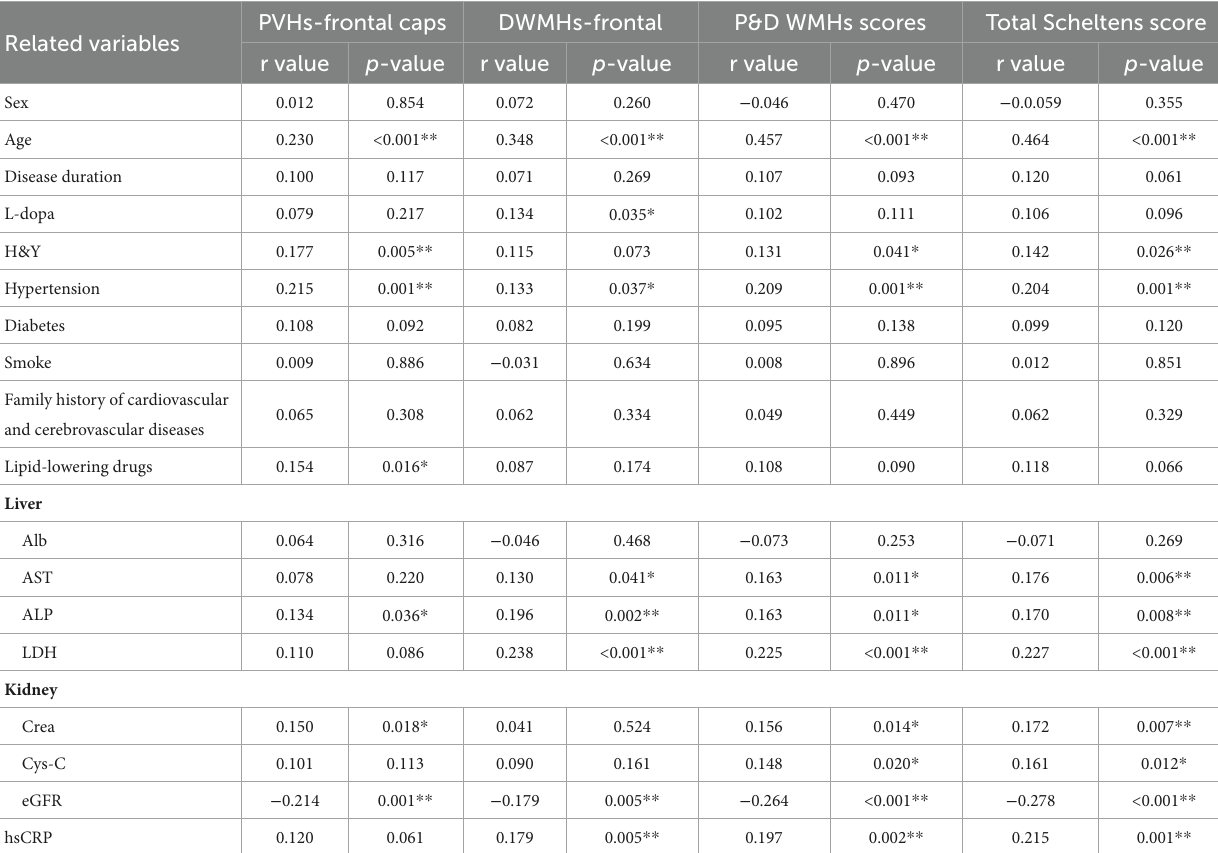
TABLE 4 Correlation analysis about the risk factors of WMHs in PD.